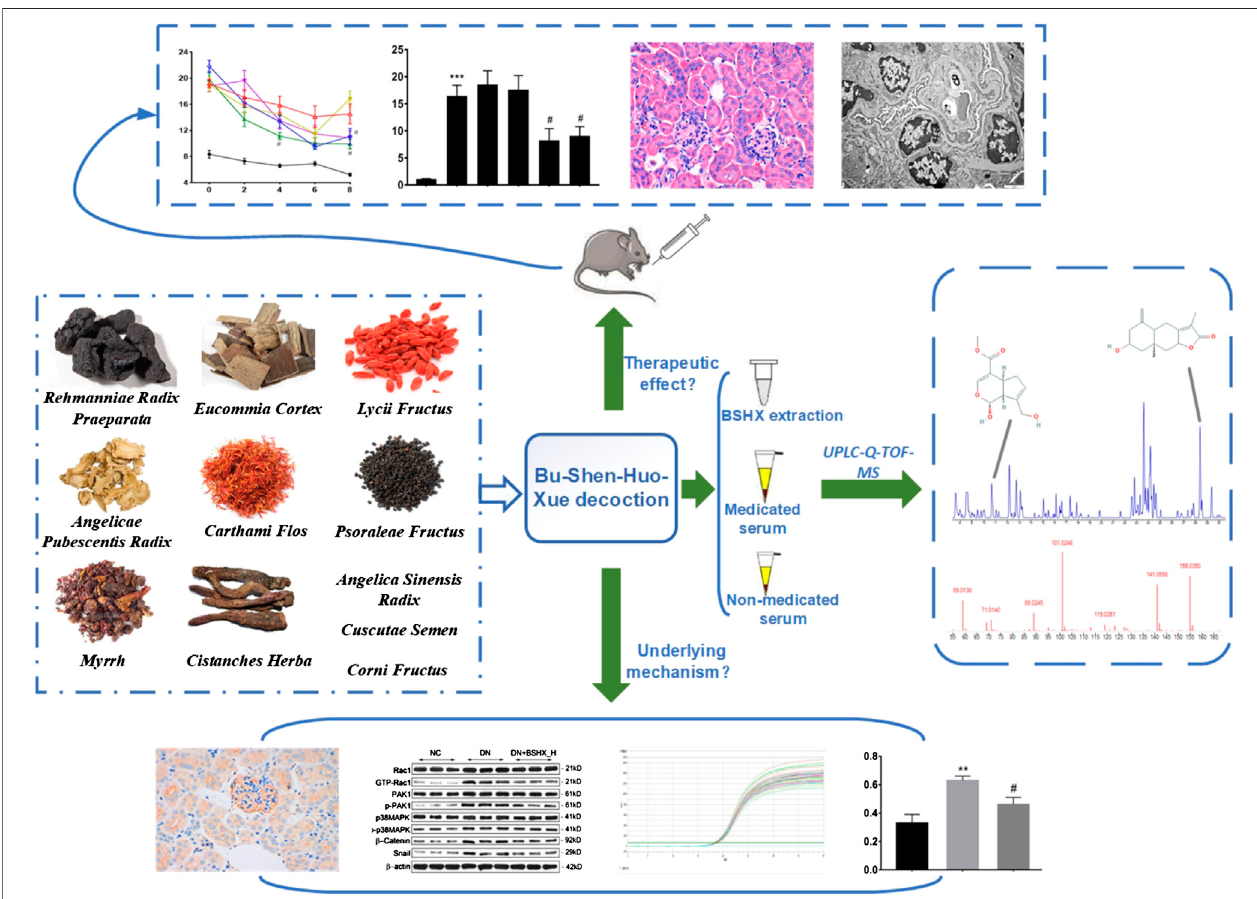
FIGURE 9 | Research conducted in this study. This study was divided into three main parts: 1) veri fi cation of the therapeutic effects of BSHX decoction in DN mice;2)ascertainmentofthecomponentsandpotentialactivecompoundsinBSHXdecoctionusingUPLC-Q-TOF-MS;and3)explorationofthemechanismunderlying BSHX decoction activity using IHC, western blot, and RT-qPCR to detect podocyte EMT markers and factors involved in Rac1/PAK1/p38MAPK signaling.